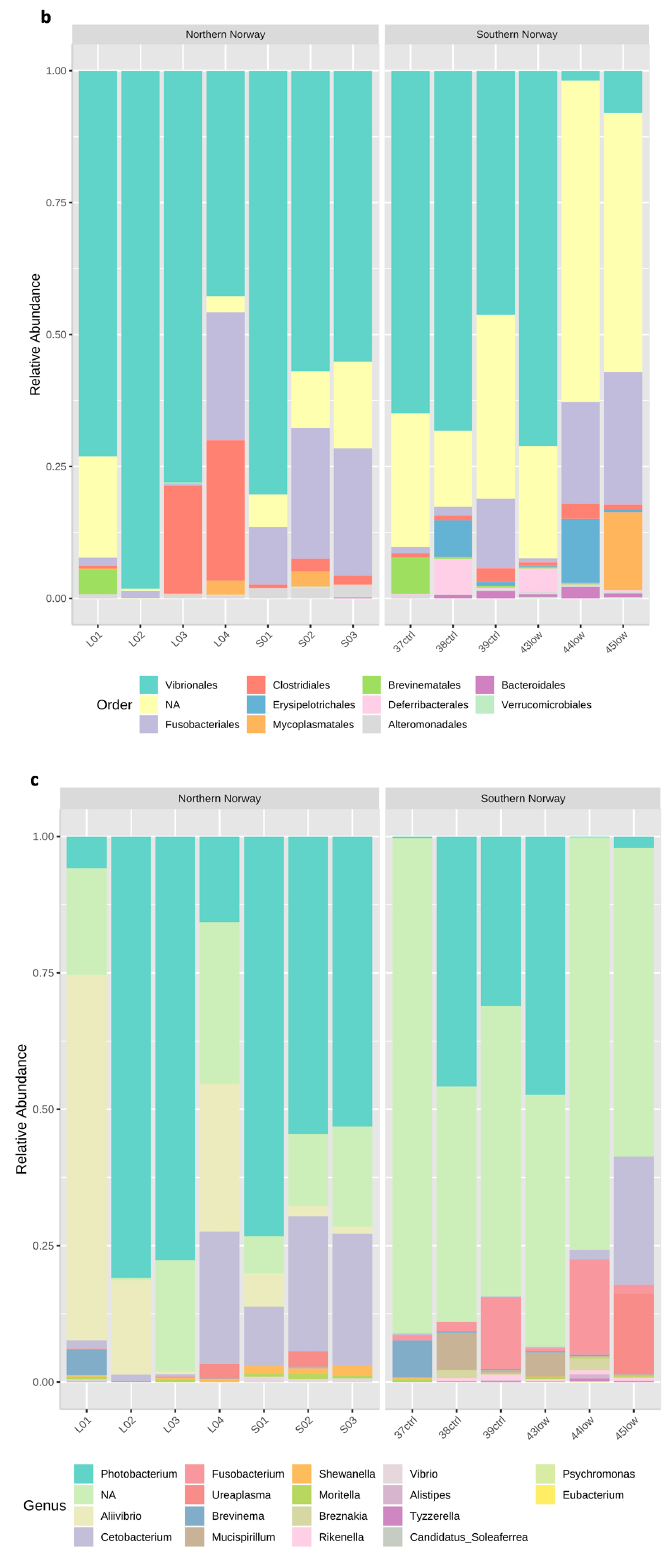
Figure 1. Microbial community composition in Atlantic cod gut samples from geographically di ff erent areas. Relative abundance of the sequences is expressed as percentage (%) and are presented at the phylum level ( a ), order level ( b ), and genus level ( c ).